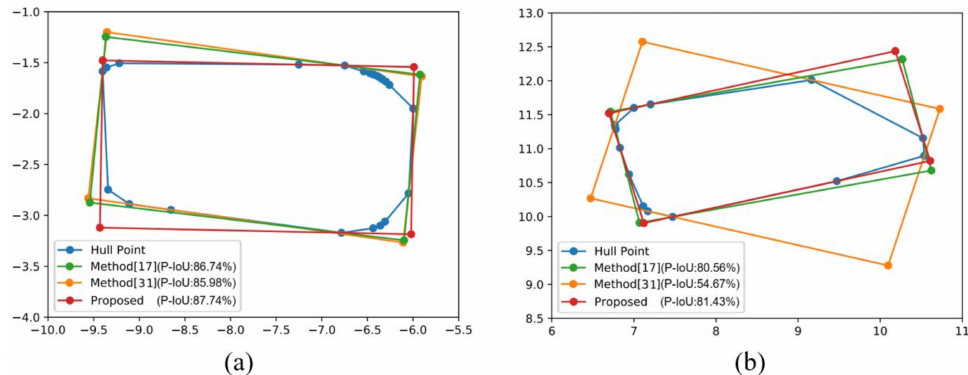
Figure 22. P-IoU evaluation effect of pose estimation in SemanticKITTI dataset: ( a ) An obstacle vehicle on a straight road section, which is the obstacle vehicle marked “a” in Figure 21. ( b ) An obstacle vehicle on a curved road section, which is the obstacle vehicle marked “b” in Figure